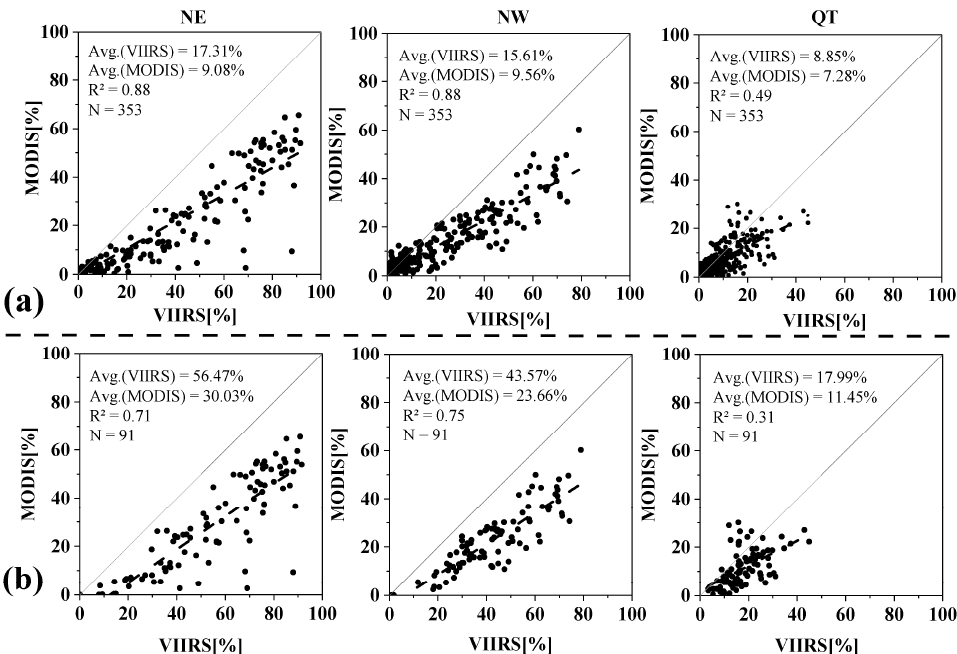
Figure 4. Scatter plots of daily SCPs in three test areas illustrating VIIRS with respect to MODIS in ( a ) the entire hydrological year and ( b ) the snow season. Each column represents the NE, NW and QT test regions from left to right. Avg. (VIIRS) represents the average SCP in VIIRS, and Avg. (MODIS) represents the average SCP in MODIS. The red line is the fitting line with the coefficient of determination (R 2 ), and N is the number of days.